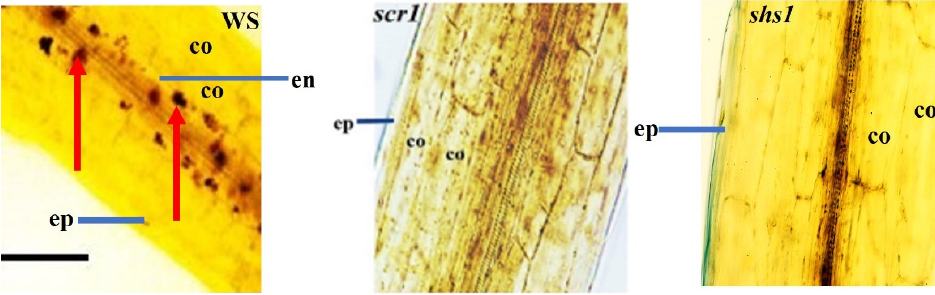
Figure 6. Analysis of Amyloplast sedimentation in hypocotyl of A. thalian suppressors. Whole- mount staining of starch in amyloplasts of hypocotyl of WS, scr1 and shs1 was performed. The red arrow indicates the sedimented amyloplasts in response to gravity. en, endodermis; co, cortex; ep, epider- mis. Scale bar, 50 µm. Scale bar, 50 µ